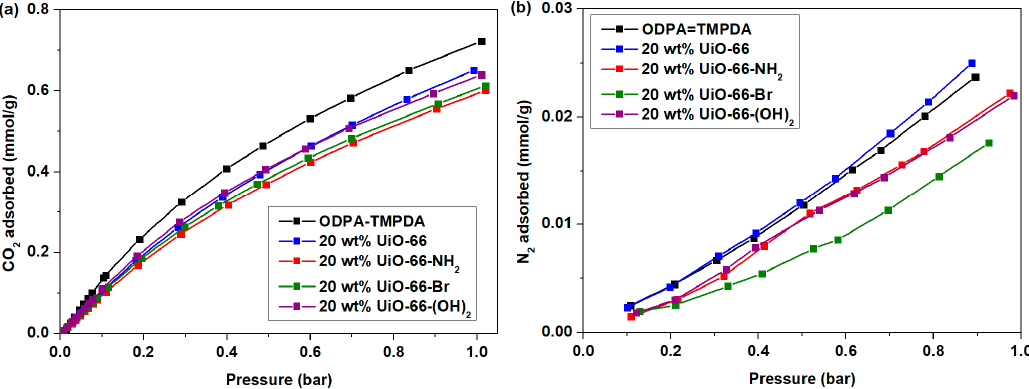
Figure 8. ( a ) CO 2 and ( b ) N 2 isotherm of ODPA-TMPDA membrane and mixed-matrix membrane containing UiO-66, UiO-66-NH 2 , UiO-66-Br and UiO-66-(OH) 2 at 20 wt% loading. Table 3. Solubility–di ff usivity data of CO 2 and N 2 on membranes measured at 35 ◦ C and total feed pressure of 1 bar. The pressure point is determined to be 0.2 bar for CO 2 and 0.8 bar for N 2.